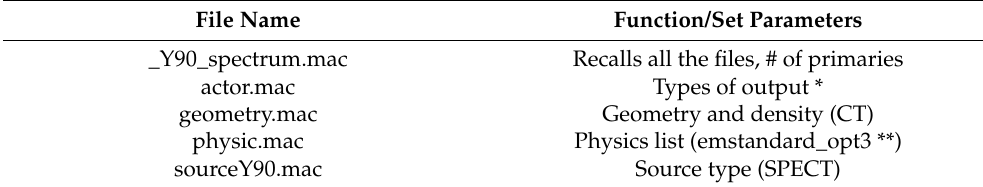
Table 2. Some .mac files generated by MCID (Monte Carlo Internal Dosimetry tool) and respective main set